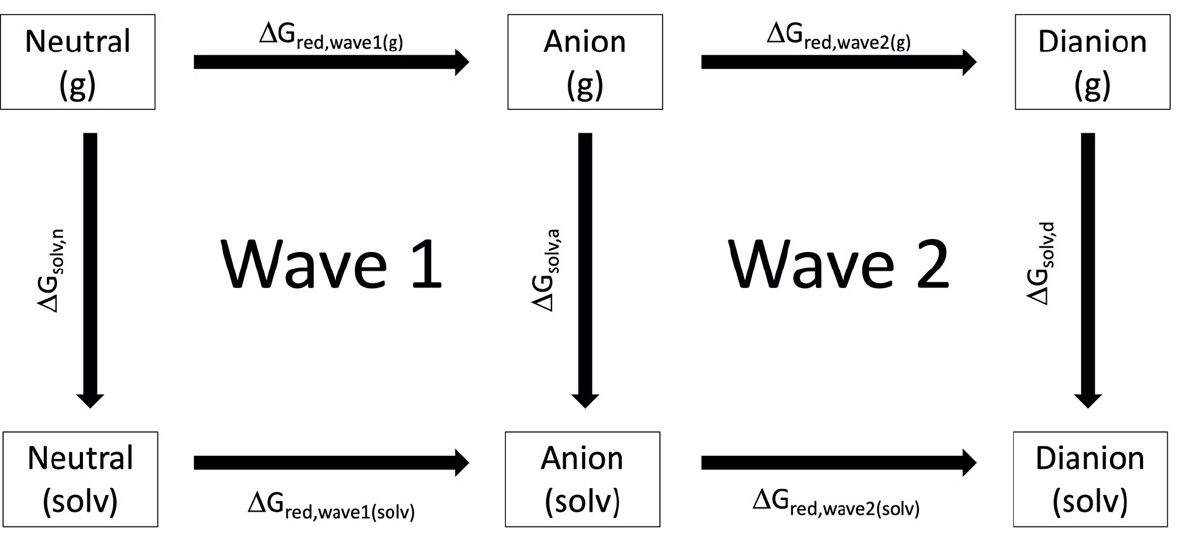
Figure 2. The thermodynamic cycle used to calculate the electrochemical cell potentials for wave 1 and wave 2.